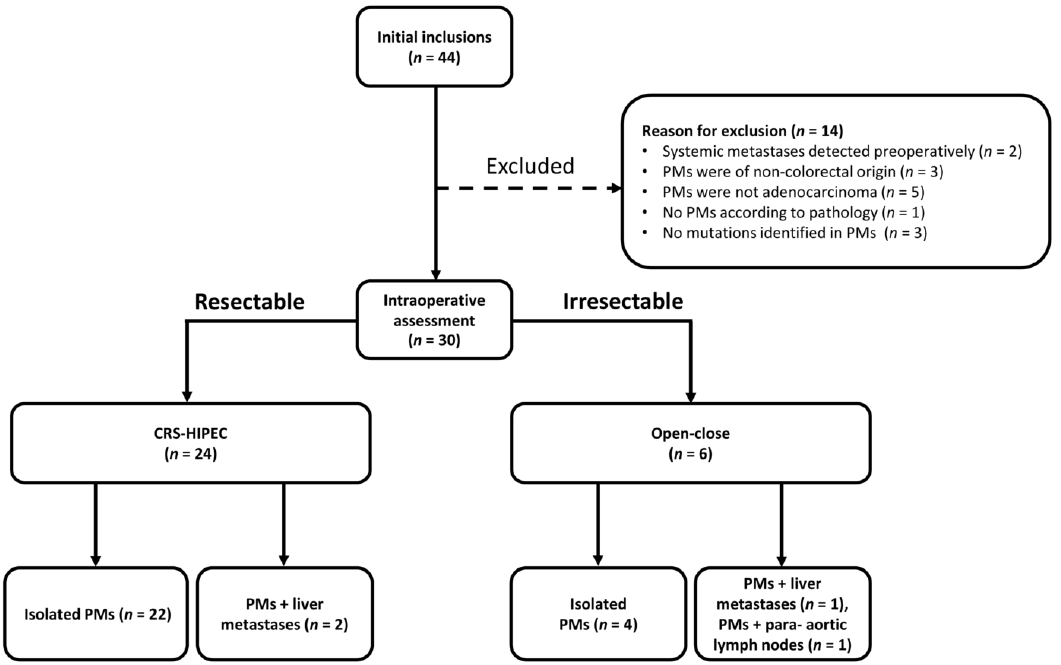
Figure 1. Flowchart of patient classification after initial inclusion in the study. The reasons for patient exclusion prior to intraoperative assessment are described. After the intraoperative assessment, patients either underwent Cytoreductive Surgery and Hyperthermic Intraperitoneal Chemotherapy (CRS-HIPEC) or received an open–close procedure. PMs: Peritoneal Metastases.